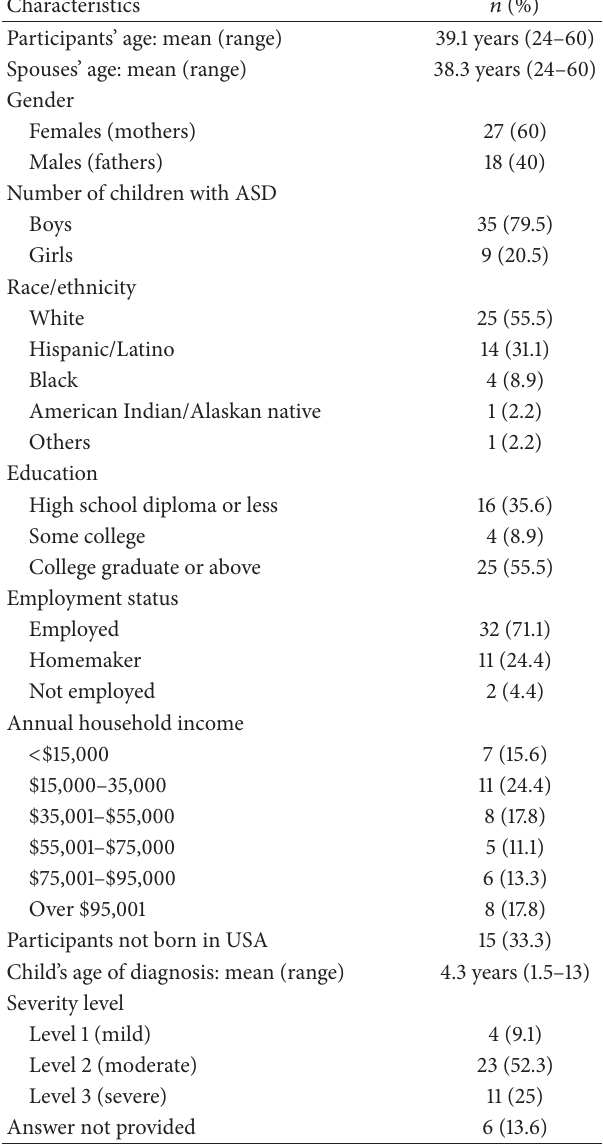
Table 1: Sample characteristics ( 𝑁 = 45